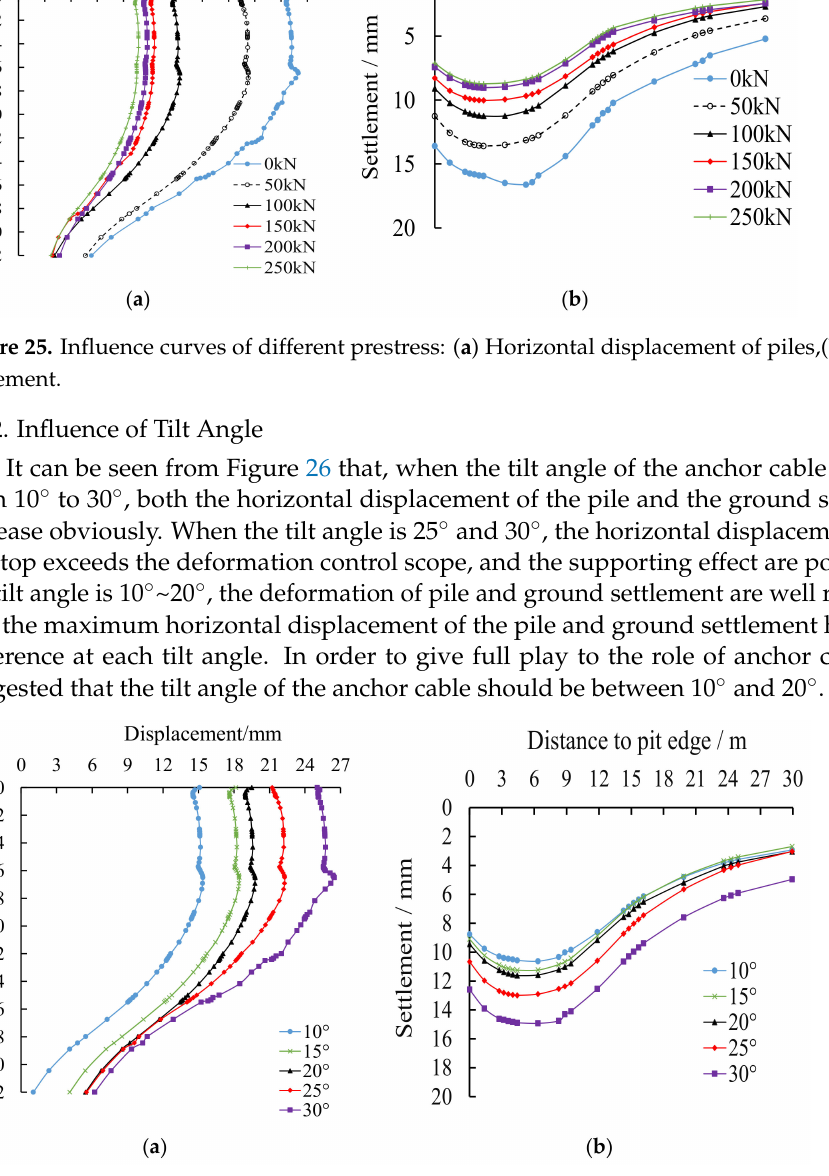
Figure 26. Influence curves of different tilt angle: ( a ) Horizontal displacement of piles, ( b ) Ground